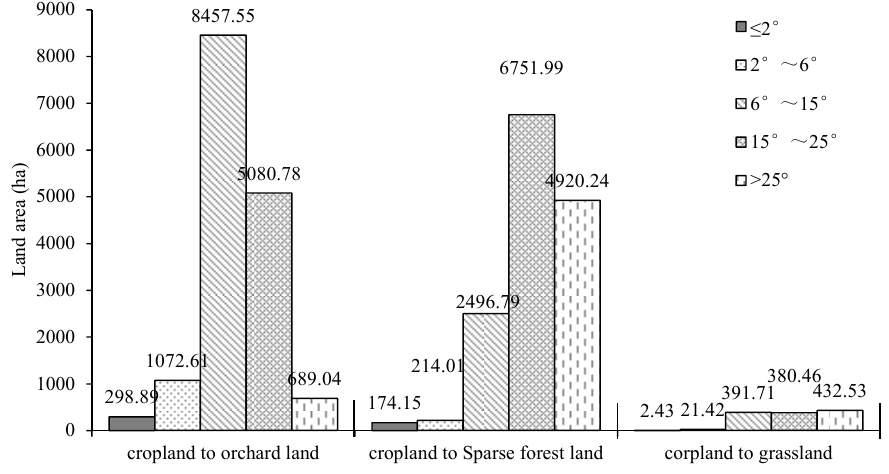
Figure 3. Distribution of converted cropland on different gradients in Yanchuan